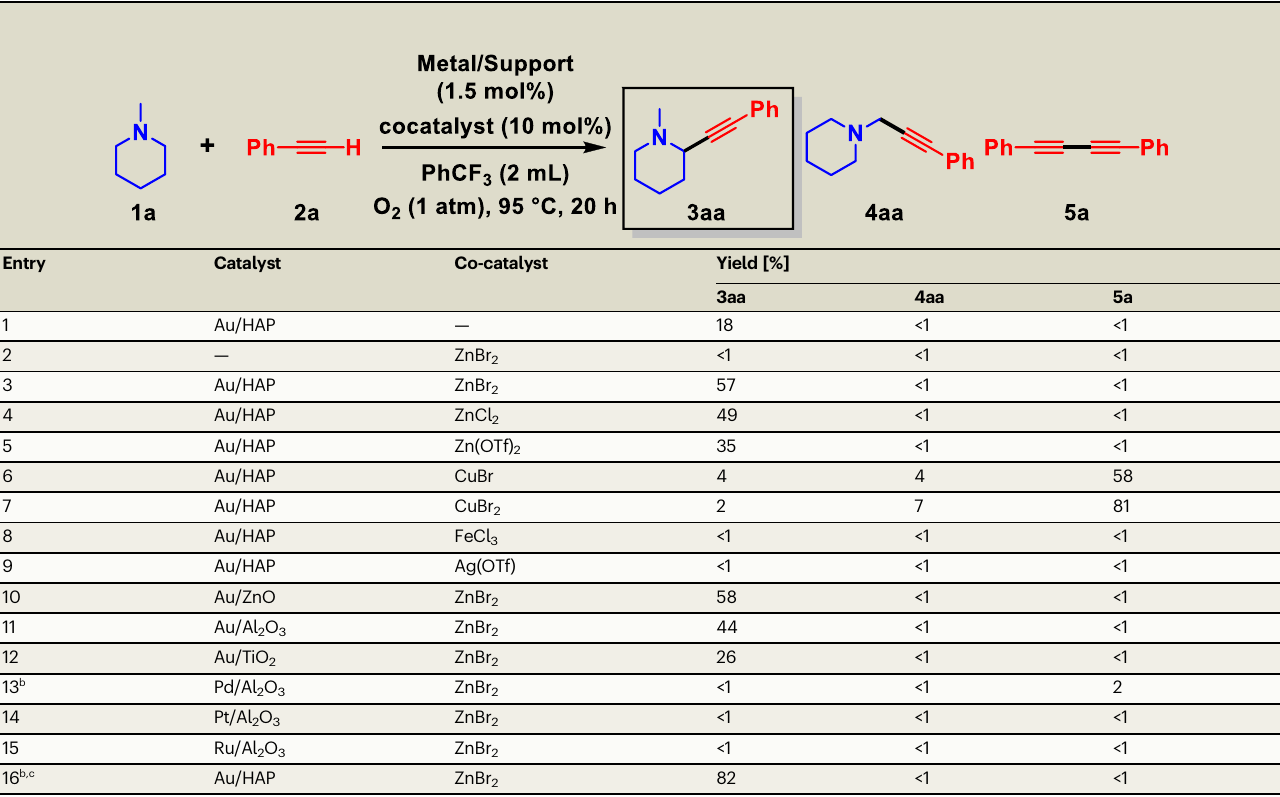
Table 1 | α -Methylene-speci fi c alkynylation of 1-methylpiperidine (1a) with phenylacetylene (2a) using various catalysts and co-catalysts